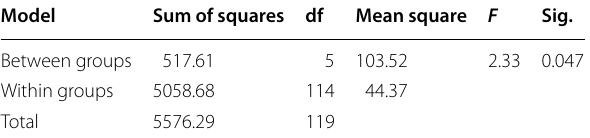
Table 8 Variance analysis results of seat pitch